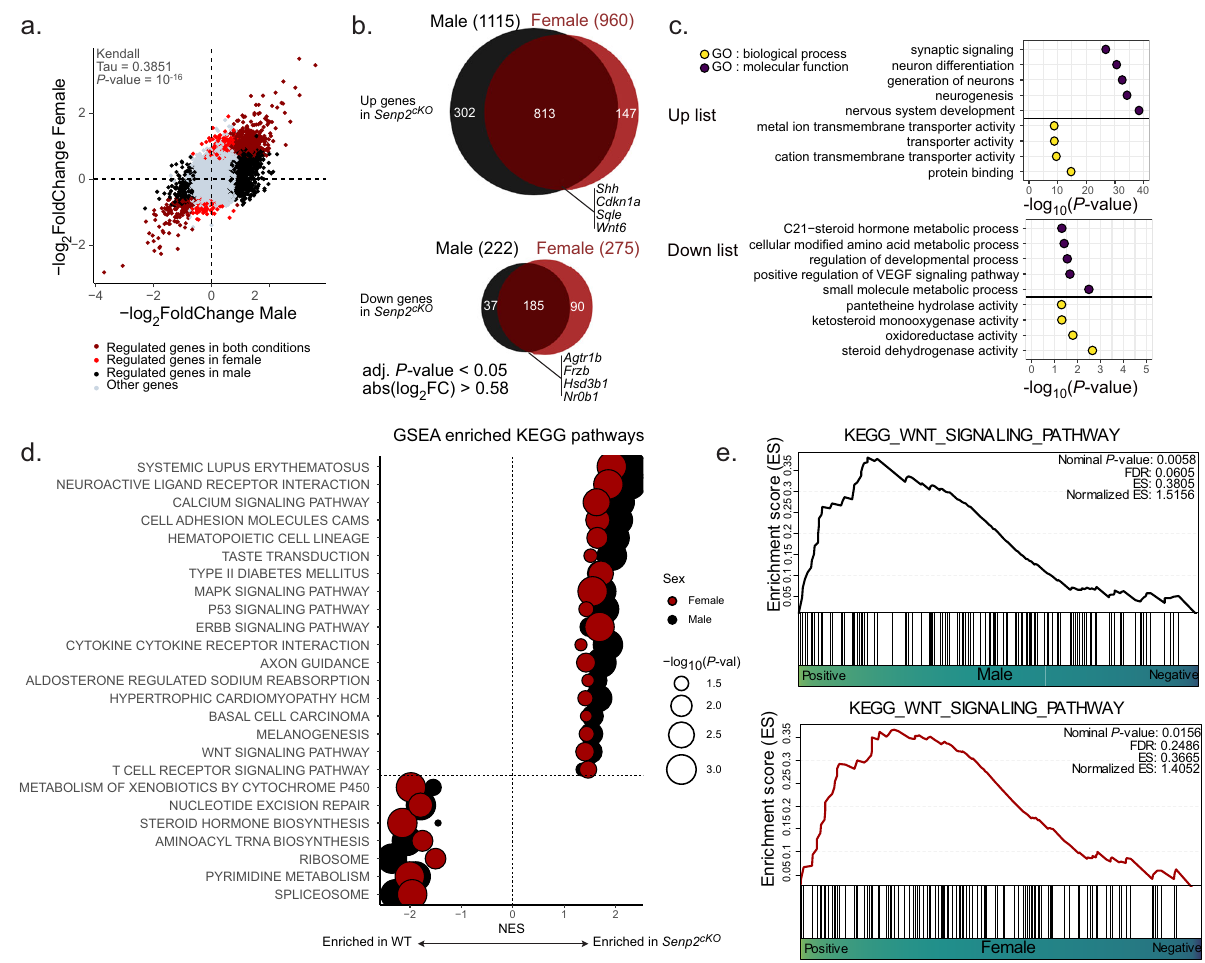
Fig. 7 | RNA-seq analysis of male and female Senp2 cKO adrenals. a Scatter plot showing the correlation between dysregulated genes (adjusted P value < 0.05 and absolutelog 2 foldchange > 0.58)inmaleandfemale Senp2 cKO adrenalsat4weeksof age.CorrelationhasbeenconductedusingKendallmethodasdistributionsdidnot follownormalityandcontainedties. b Eulerdiagramsillustratingthecommonlyup ordownregulatedgenesinbothsexes Senp2 cKO adrenalsat4weeksofage. c TopGO